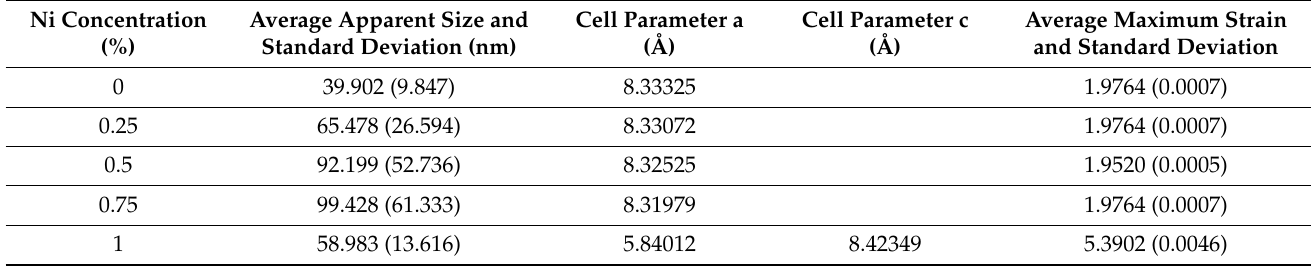
Table 1. Calculated crystallographic parameters.